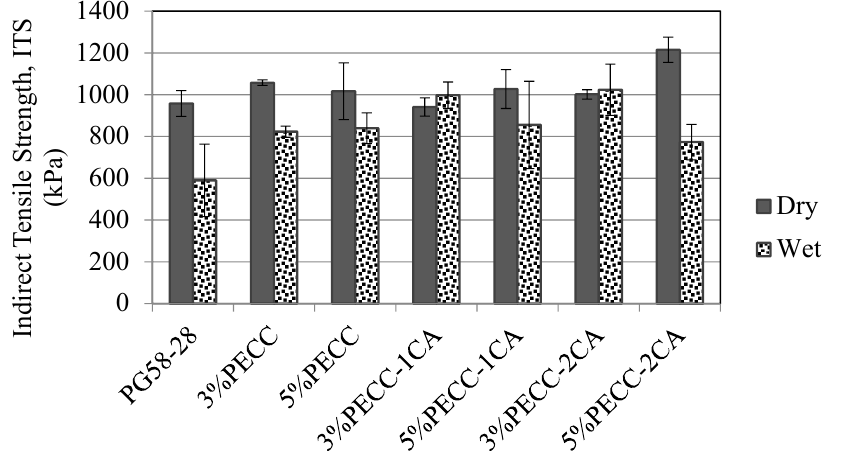
Figure 12. ITS test results.